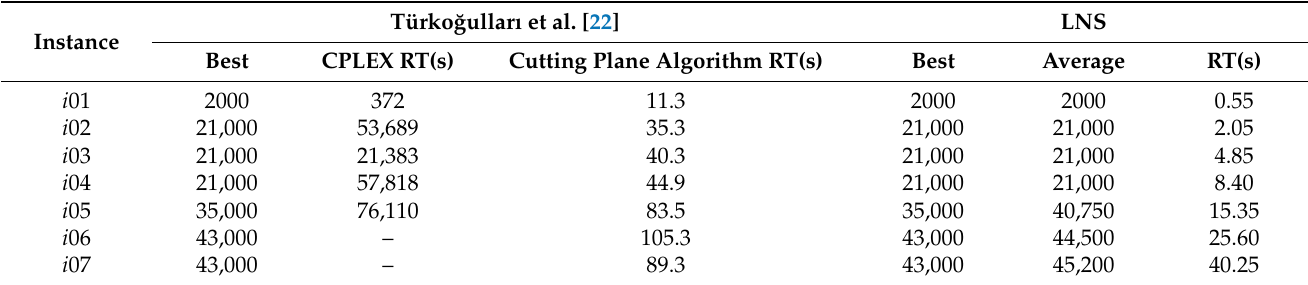
Table 5. Comparison results of the LNS algorithm and CPLEX solver for solving the BACASP.